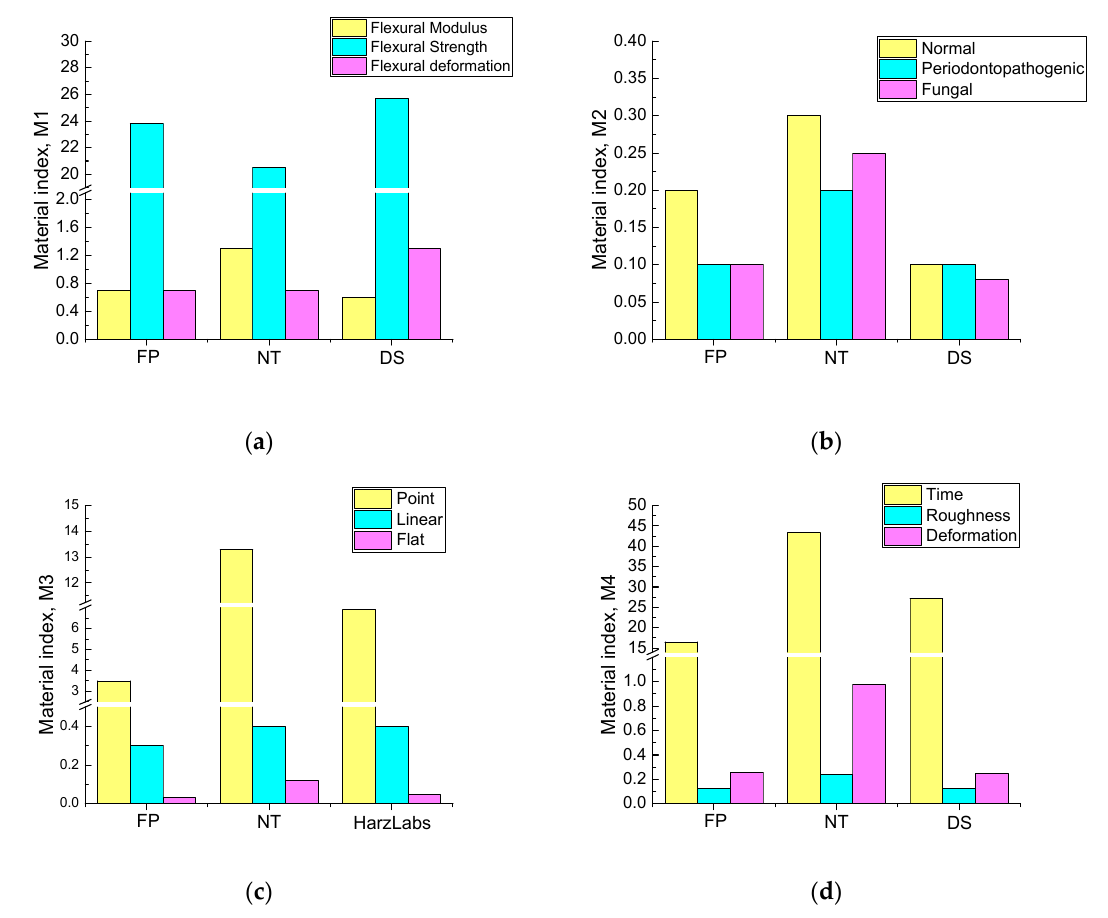
Figure 2. The material indices of the studied dental materials: M1 is the ratio of the mechanical properties to the feedstock cost ( a ), M2 is the ratio of the biological properties to the feedstock cost ( b ), M3 is the ratio of the tribological properties to the feedstock cost ( c ), M4 is the ratio of the technological properties to the feedstock cost ( d ).